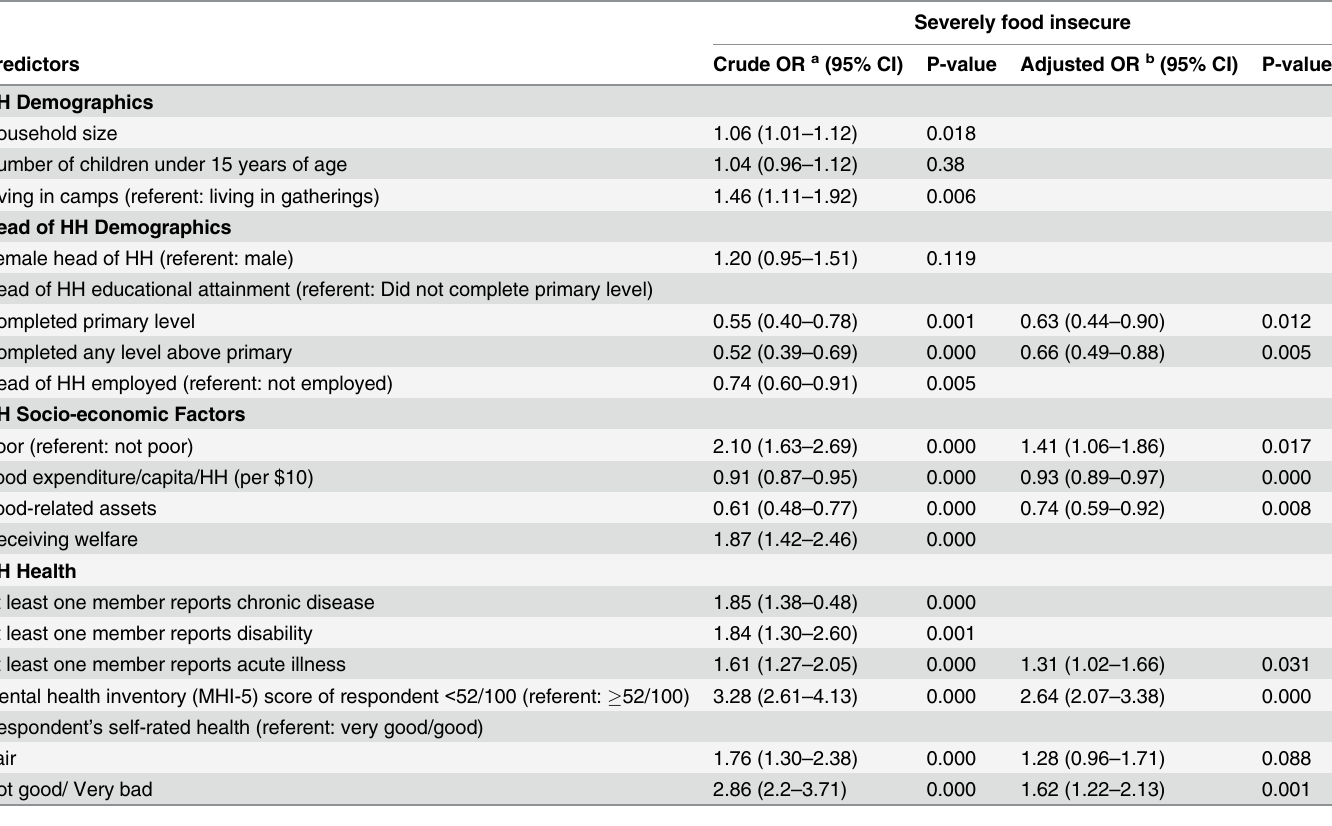
Table 2. Logistic regression model for predictors of severe food insecurity among Palestinian refugee households in